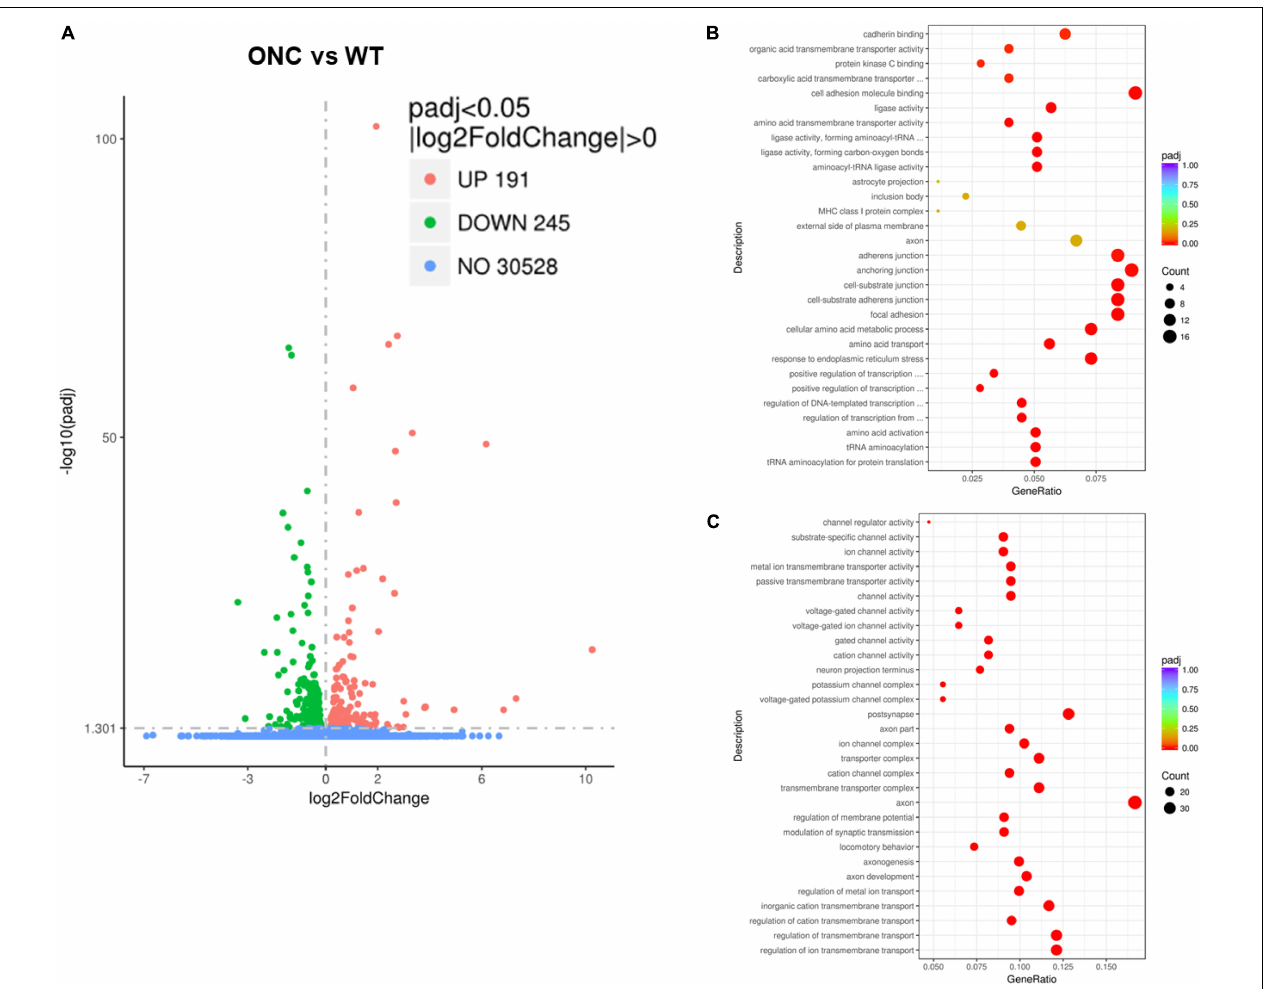
FIGURE 3 | Differentially expressed genes induced by ONC injury. (A) The volcano map shows the overall differentially expressed genes after ONC injury, compared with WT control. (B) Enriched gene ontology analysis of up-regulated DEGs. (C) Enriched gene ontology analysis of down-regulated DEGs. padj: adjusted p